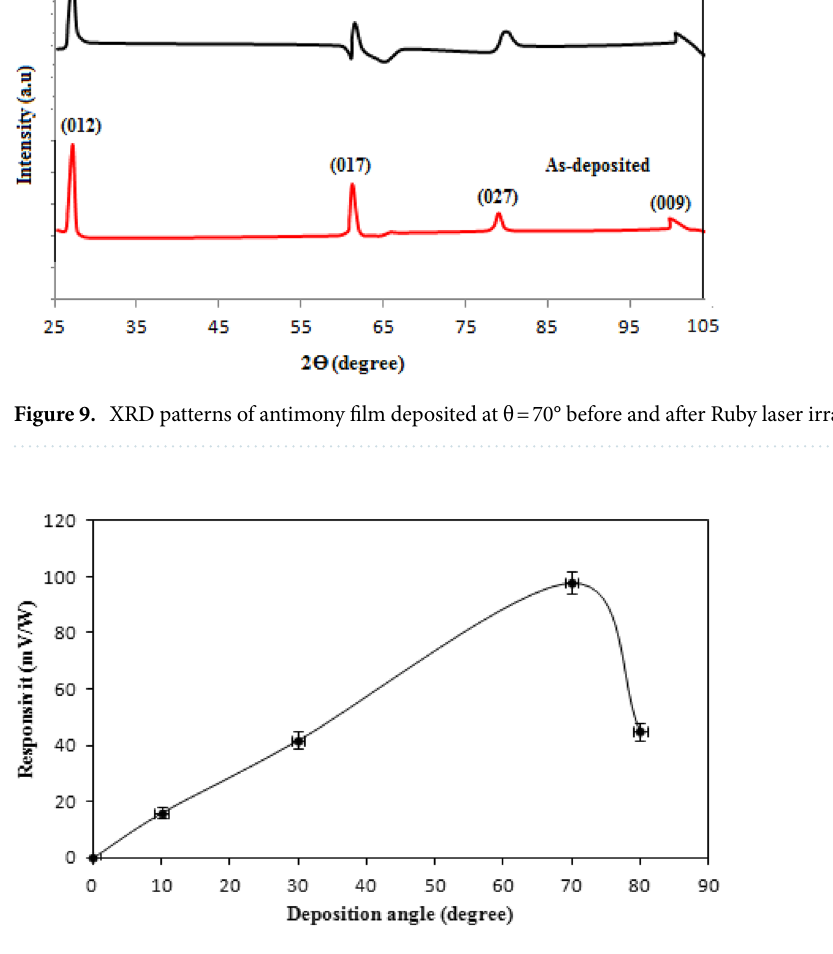
Figure 10. Responsivity of Sb detector prepared at different angles for Nd: YAG laser pulses without using